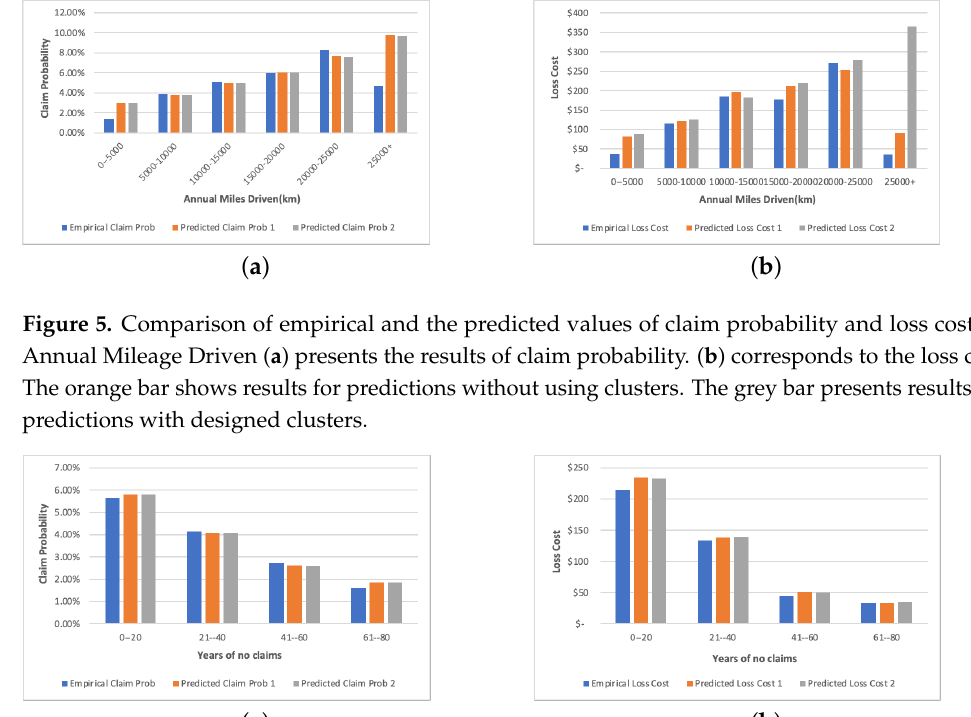
Figure 4. Comparison of empirical and predicted values of claim probability and loss cost by Credit Scores. ( a ) presents the results of claim probability. ( b ) corresponds to the loss cost. The orange bar shows results for predictions without using clusters. The grey bar presents results for predictions with designed clusters.